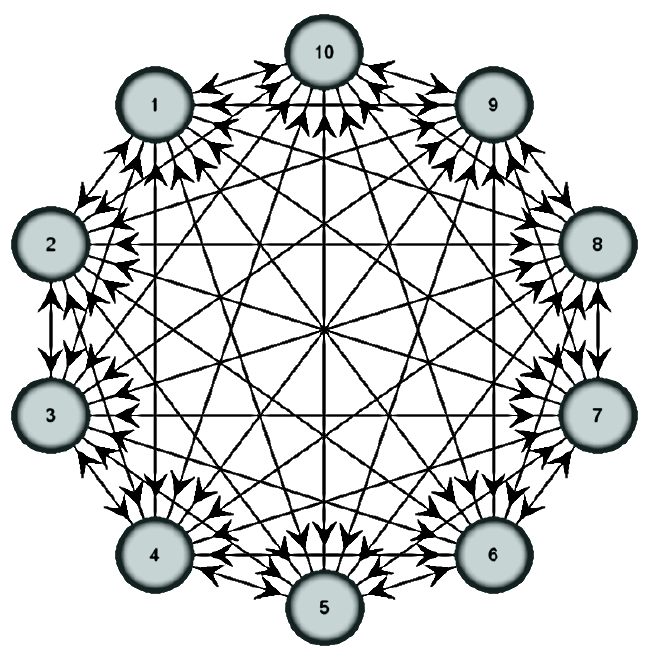
Figure 1. Material optimization attributes graph.